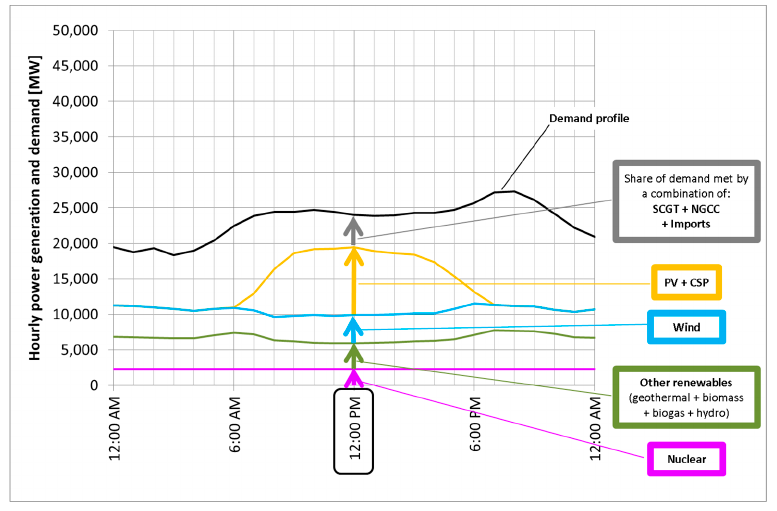
Figure 2. Historical hourly generation and demand profiles for the day of 2 April 2018 in California, from CAISO data.